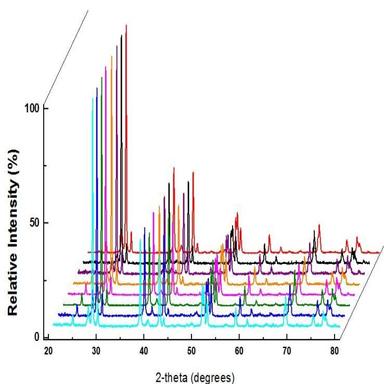
.XRD patterns of Mn1-xCoxBi samples.